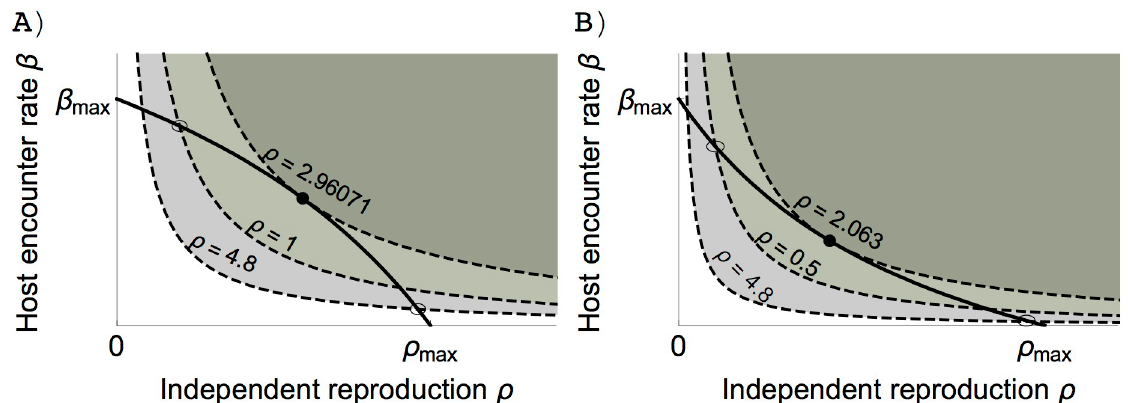
Fig 3. Invasion boundaries as a function of different levels of resident investment in the independent reproduction rate are represented by dashed lines. Open circles indicate the values of the traits of the residents. Shaded areas are invasion areas. Trade-off is assumed as in Fig 2. Free host population is ^ H ¼ N (cid:0) ^ A , where N is the total number of hosts. ESS value is the tangent point (closed circle) between the invasion boundary and the convex trade-off curve (A) and concave trade-off curve (B). Parameter values: b = 3, ν = 3, c = 2, σ